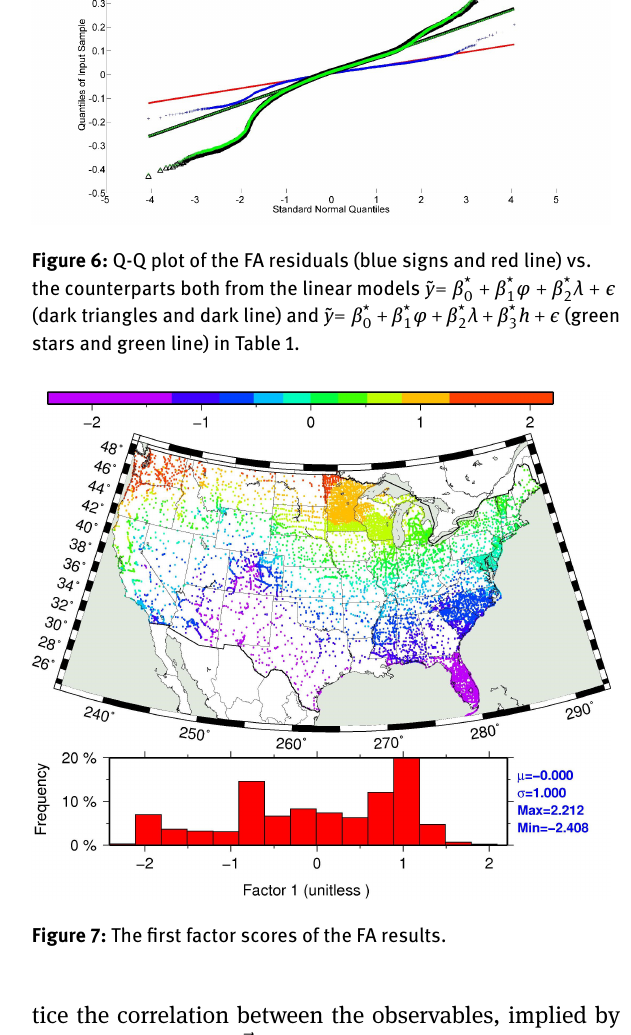
tice the correlation between the observables, implied by the common factors (cid:126) F i , and the loading matrix W .